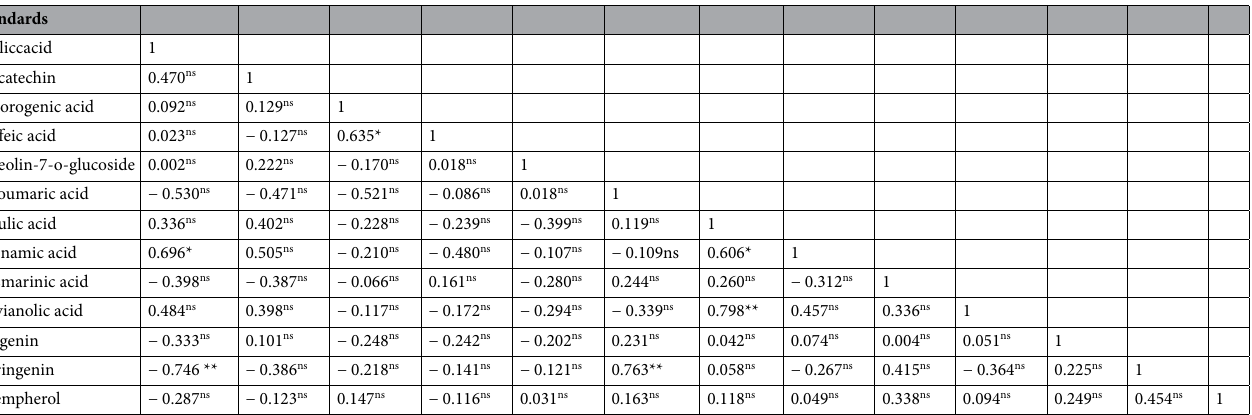
Table 4. Correlation coefficients between phenolic compounds using HPLC on studied Thymus species. *Correlation is significant at the 0.05 level. **Correlation is significant at the 0.01 level. ns. Not